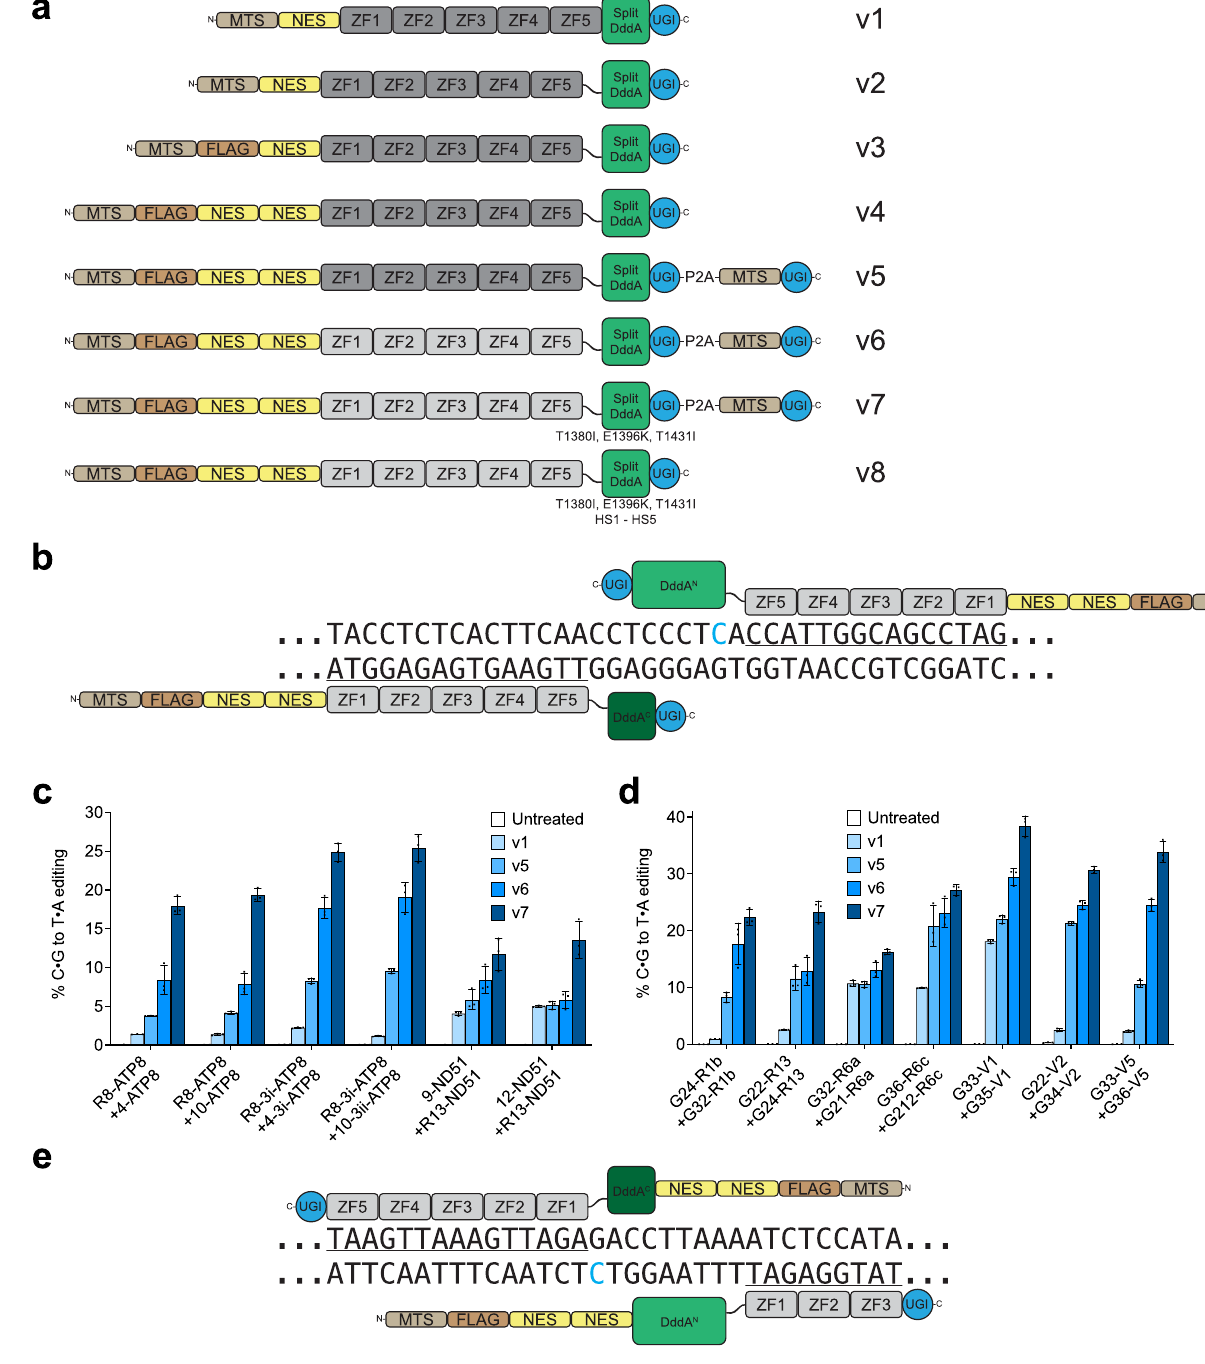
Fig. 1 | Optimizing ZF-DdCBEs increases base editing ef fi ciency in mitochon- dria. a Architectures of optimized ZF-DdCBEs showing progression from v1 to v8. The components are a mitochondrial targeting signal, FLAG tag, nuclear export signal(s), ZF array with either canonical ZF scaffold (dark grey) or optimized ZF scaffold (light grey), Gly/Ser-rich fl exible linker, split DddA deaminase (with or without activity-enhancing mutations and speci fi city-enhancing mutations) and UGI. b A v8 ZF-DdCBE pair with canonical C-terminal architecture. The ZF-DdCBE pairshownis9-ND51+R13-ND51. c , d MitochondrialDNAbaseeditingef fi